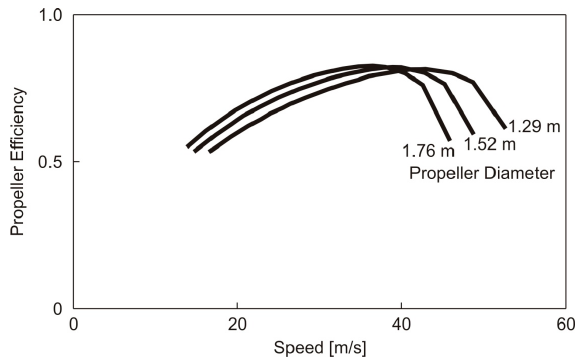
Figure 7. Propeller efficiency for an ultralight vehicle (reproduced in part from [25]).